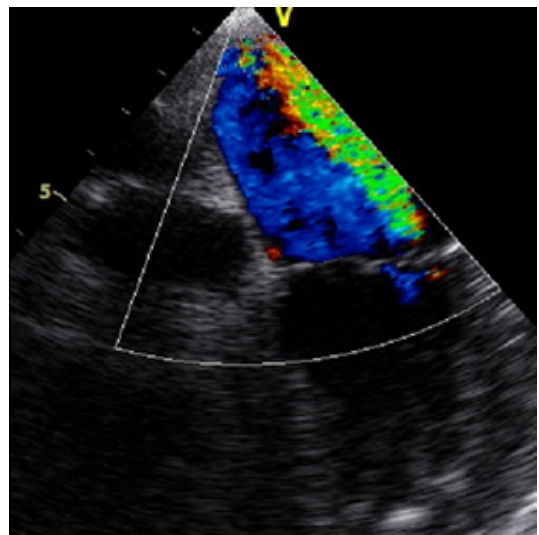
Figure 4: Mild to moderate mitral